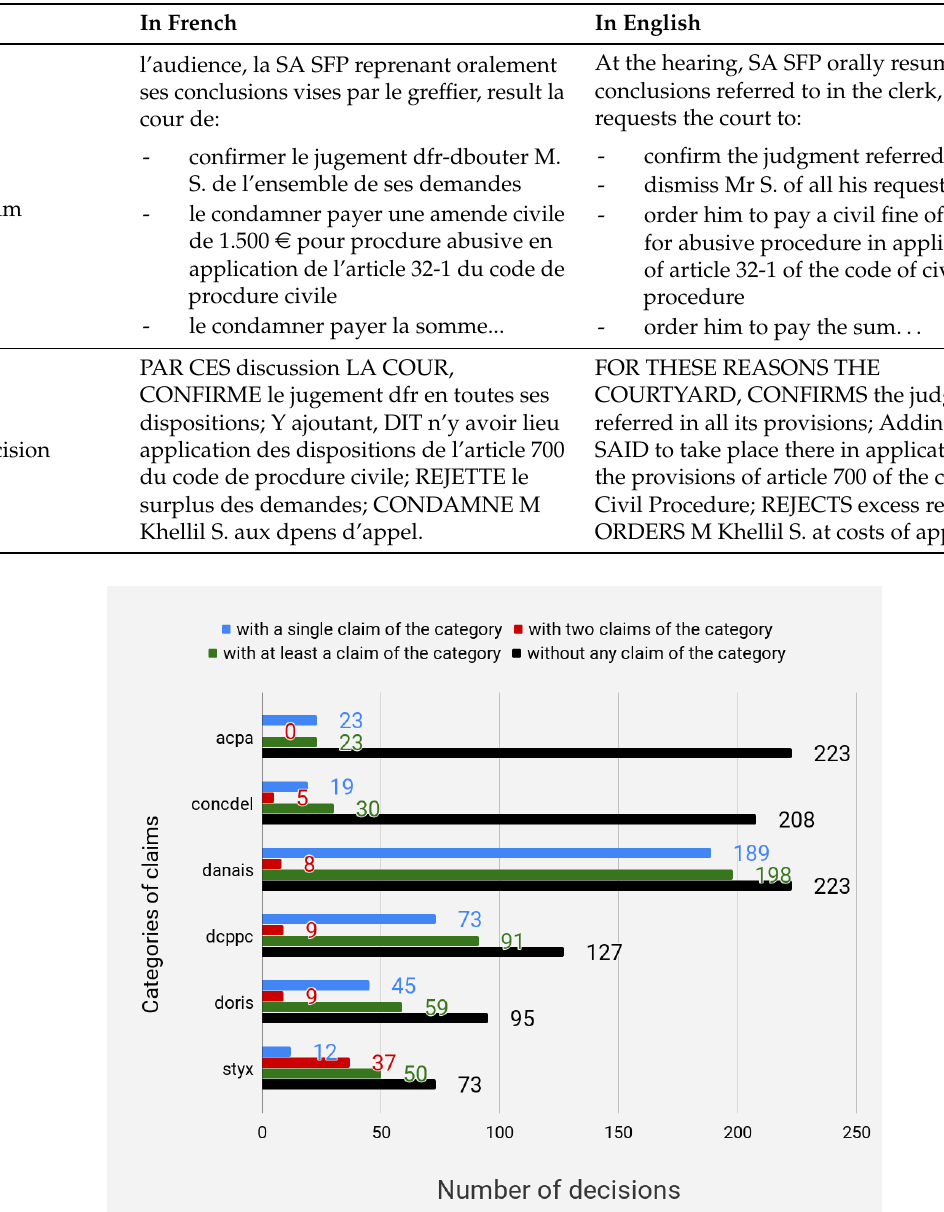
Table 2. Extract from “Cour d’appel, Paris, Pôle 6, chambre 9, 18 Mai 2016 n ◦ 14/11380”.